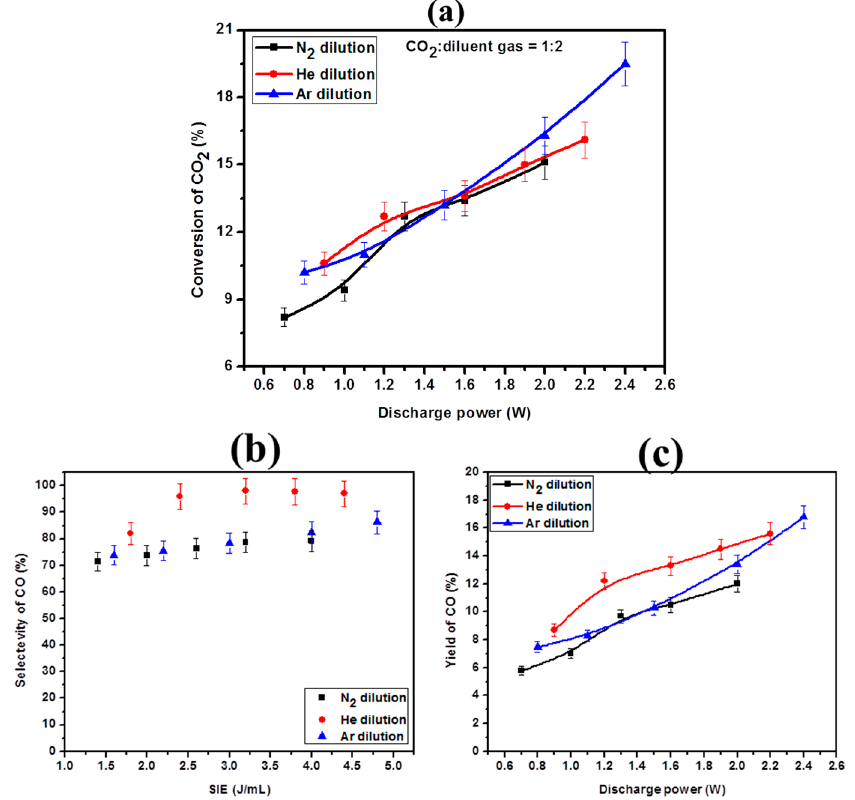
Figure 6. ( a ) CO 2 conversion with respect to discharge power; ( b ) CO selectivity with respect to SIE; ( c ) CO yield with respect to discharge power. (Flow rate 30 mL/min, CO 2 :diluent gas = 1:2, Glass beads packed, Plasma frequency 50 Hz).